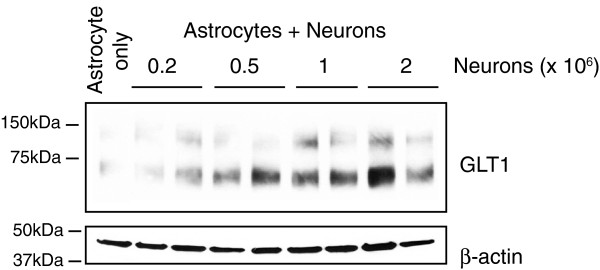
Expression of GLT1 in cultured astrocytes is induced by co-cultured neurons in a dose-dependent manner.